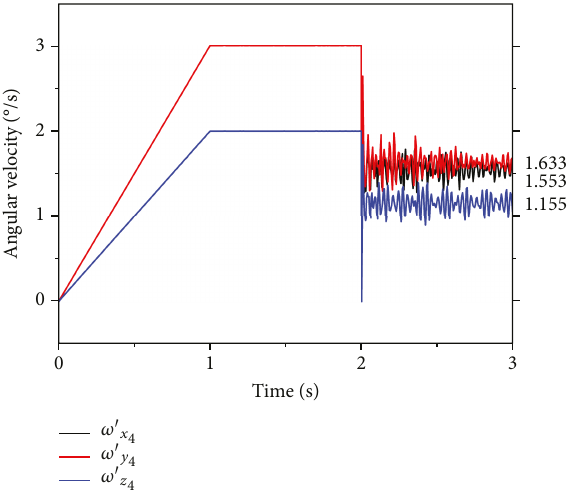
′ = 3 , ω ′ = 3 , and ω x y